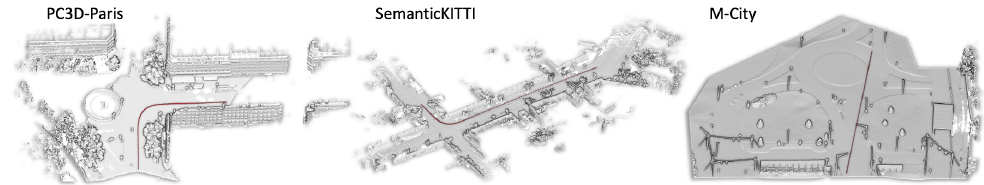
Figure 6. Point clouds used in the experiments (left to right:) PC3D-Paris, SemanticKITTI, and M-City. In red, we show the trajectory used for